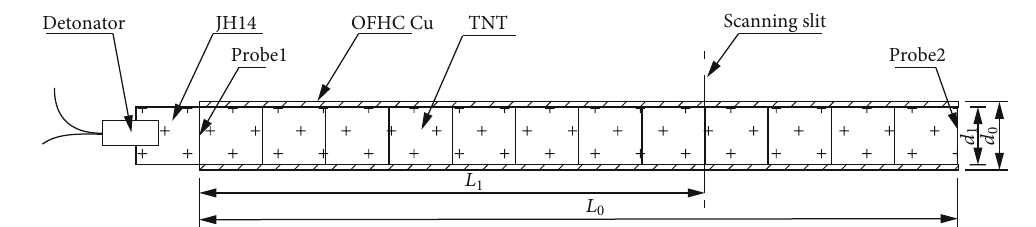
Figure 2: The con fi guration of cylinder with charges.